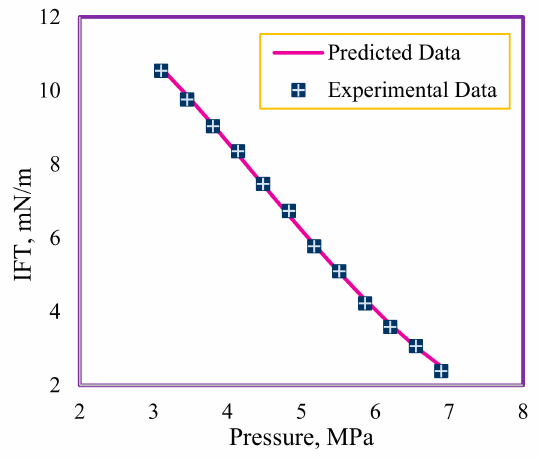
Figure 6. Experimental IFT and estimated values using the RBF-ICA model at 313.15 K and different pressures.